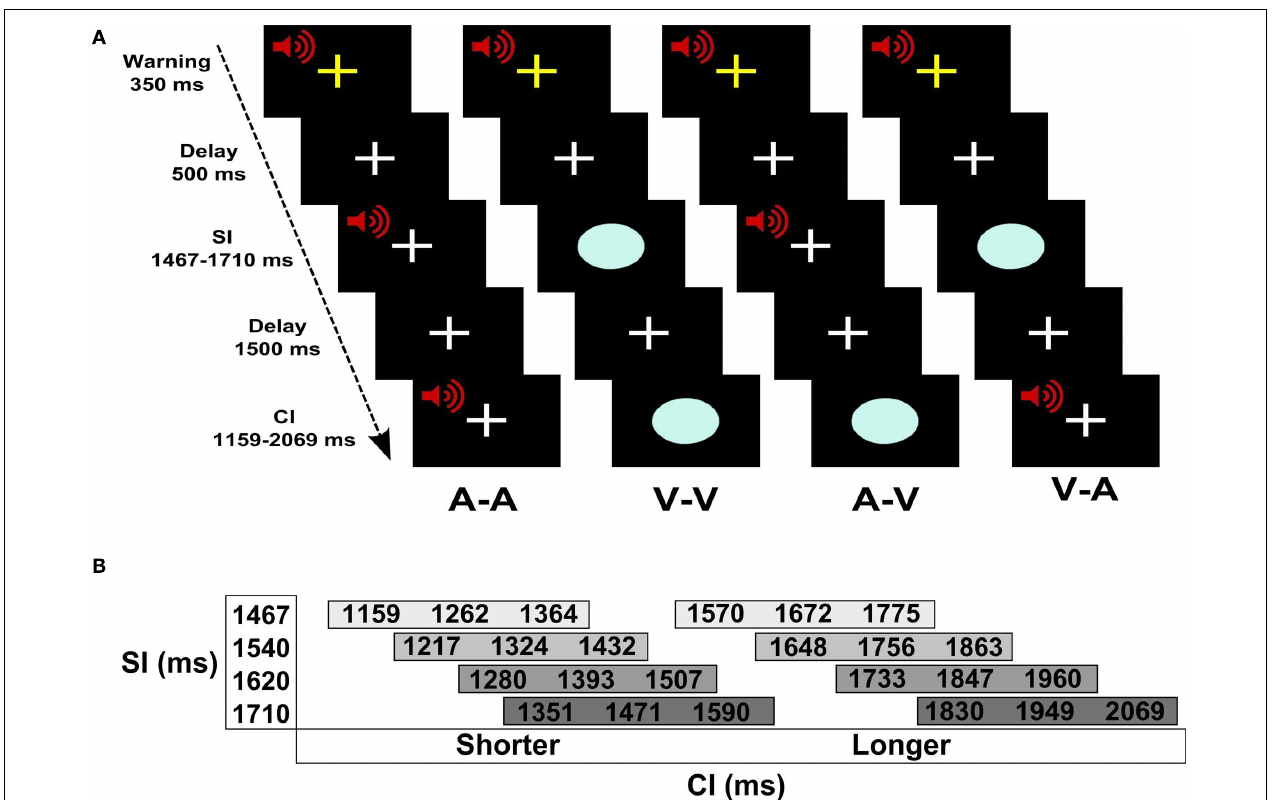
350ms followed by a 500-ms delay. A trial began with the presentation of the SI, followed by a 1.5-s delay, and then the CI.The participant indicated if the CI was shorter or longer than the SI by pressing a key with the right index or middle finger, respectively. (B) SI and CI durations.There were four different SIs. Each SI was paired with three shorter and three longer CIs that differed from the SI by successive increments of ±